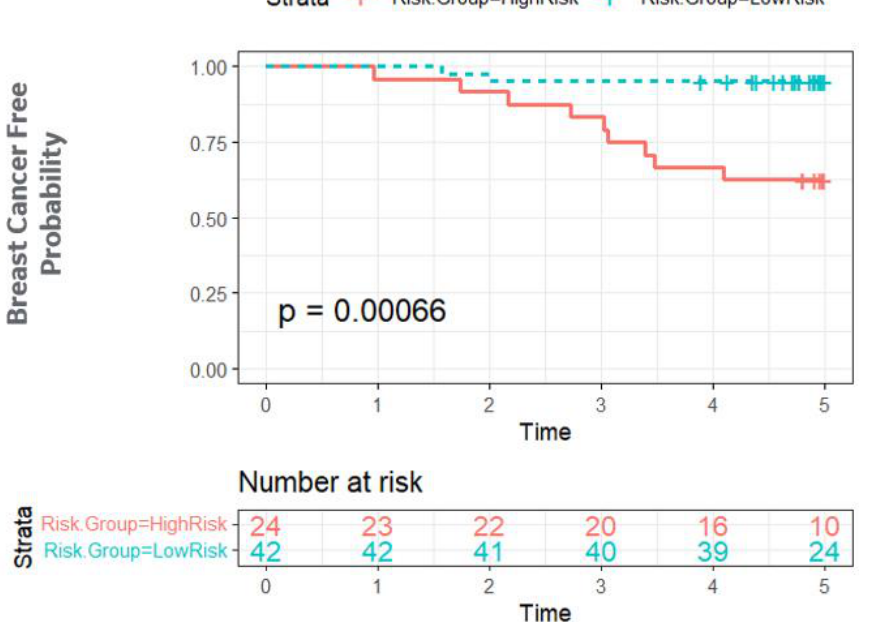
Figure 4. Kaplan–Meier plot on the integrated prediction of breast cancer event in the Singapore cohort (validation dataset). We divided the data into two groups based on the prediction from the Bayesian network (LOOCV prediction) and evaluated breast cancer events over 5 years.